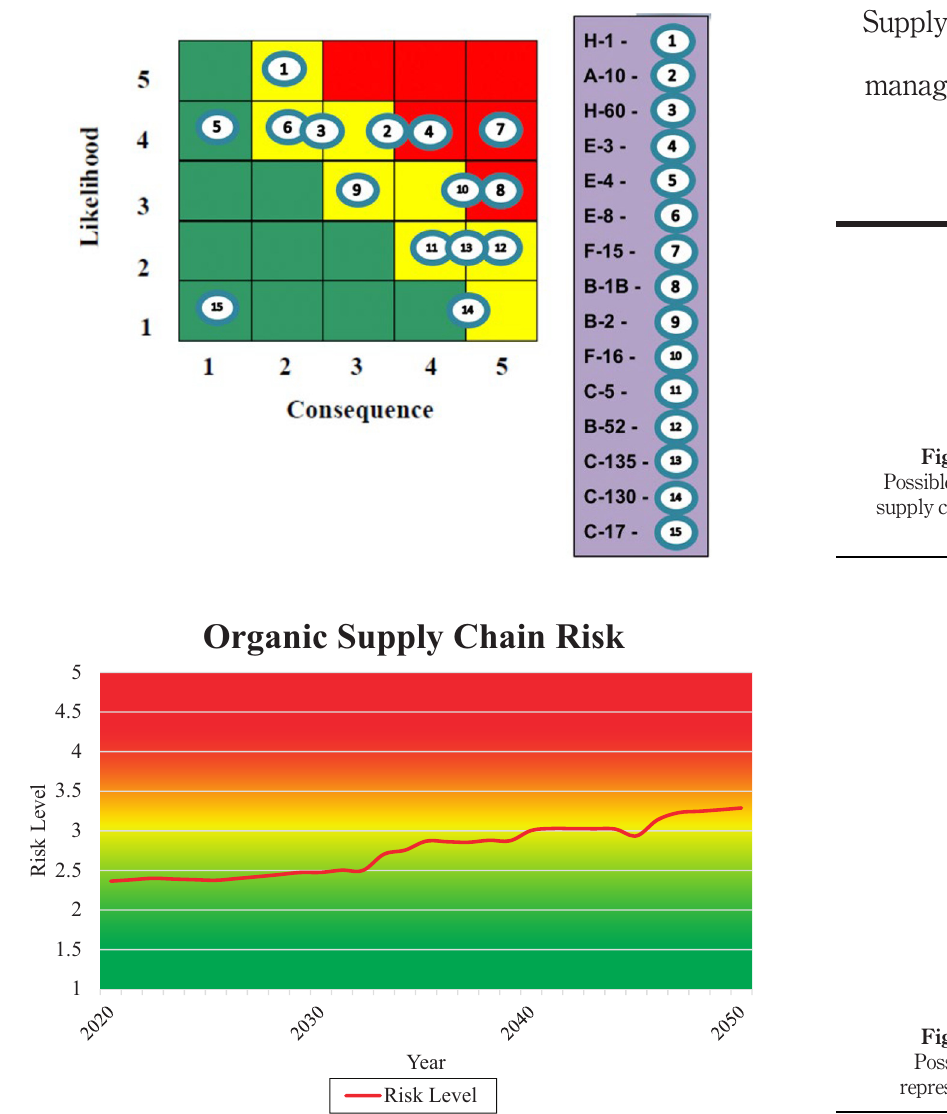
Figure 11. Possible